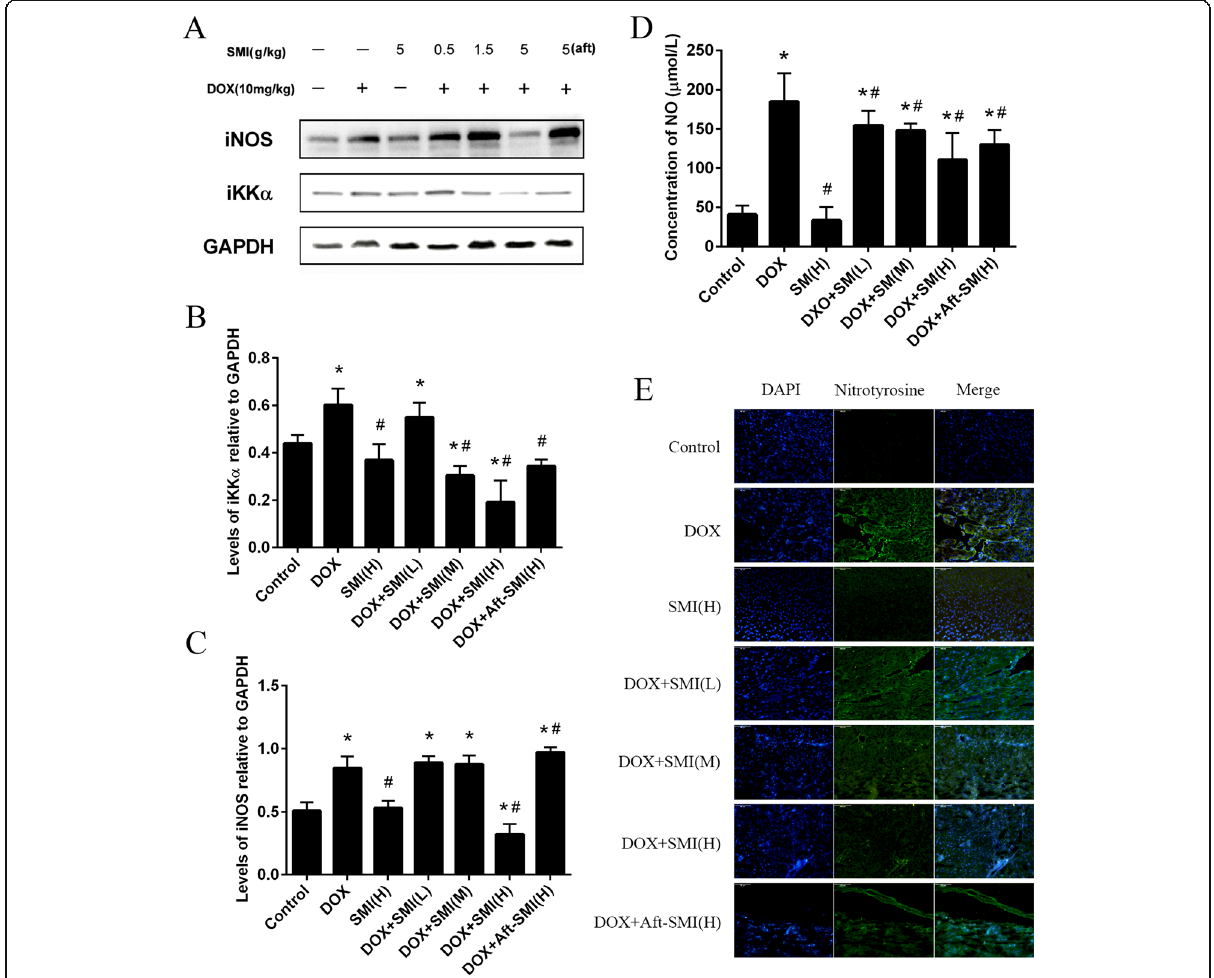
Fig. 7 Mice received different treatment in experiment. And IKK- α and iNOS expressions were detected by Western blot analysis into tissue homogenates from mice heart; GAPDH protein expression was used as loading control ( a – c ). Effect of DOX on NO release was evaluated by NO level in the serum of mice ( d ). (Means ± S.D., n = 10). *, significantly different ( P < 0.05) from respective values in the control group;#, significantly different ( P < 0.05) from respective values in the DOX group. Nitrotyrosine production in heart of ICR mice treat with DOX or SMI ( e ). Frozen myocardial tissue sections were stained with Anti-Nitrotyrosine (green) and nucleus with DAPI (blue) and were determined by immunofluorescence analysis. (Bar 200 μ